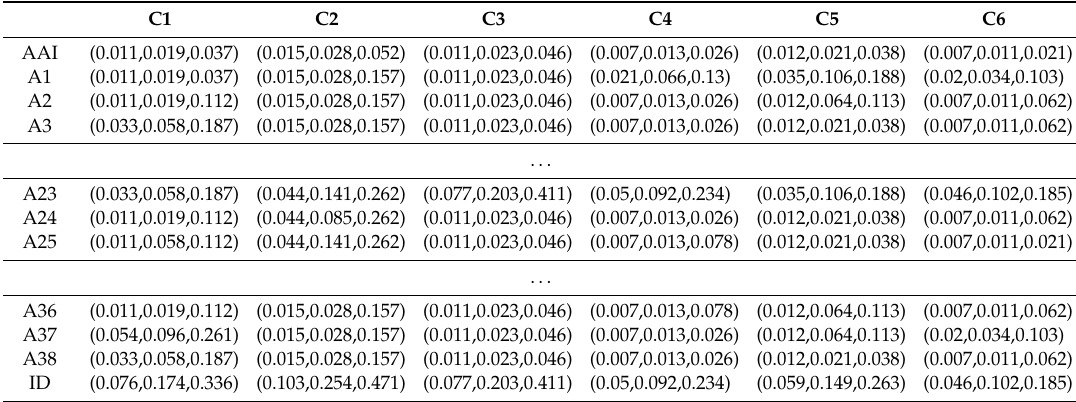
Table 5. Fuzzy weighted normalized decision